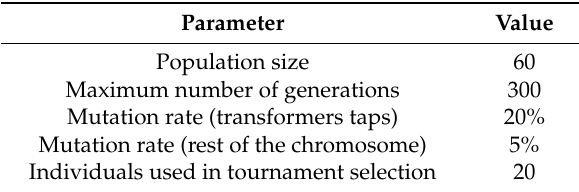
Table 2. Genetic Algorithm parameters.